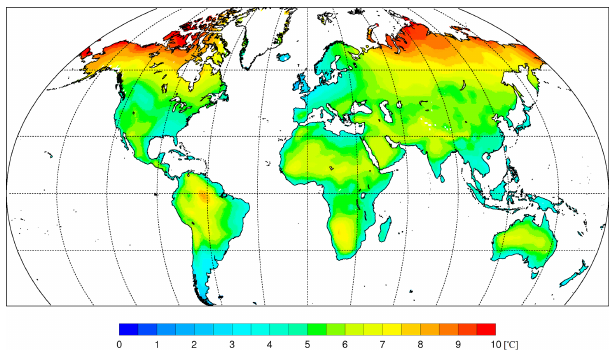
Figure A4. Anthropogenic N deposition change during the 21st century, simulated with the CAM model (Gent et al., 2010) under RCP 8.5. Shown is the difference between average values computed for 1990–2000 and 2090–2100.